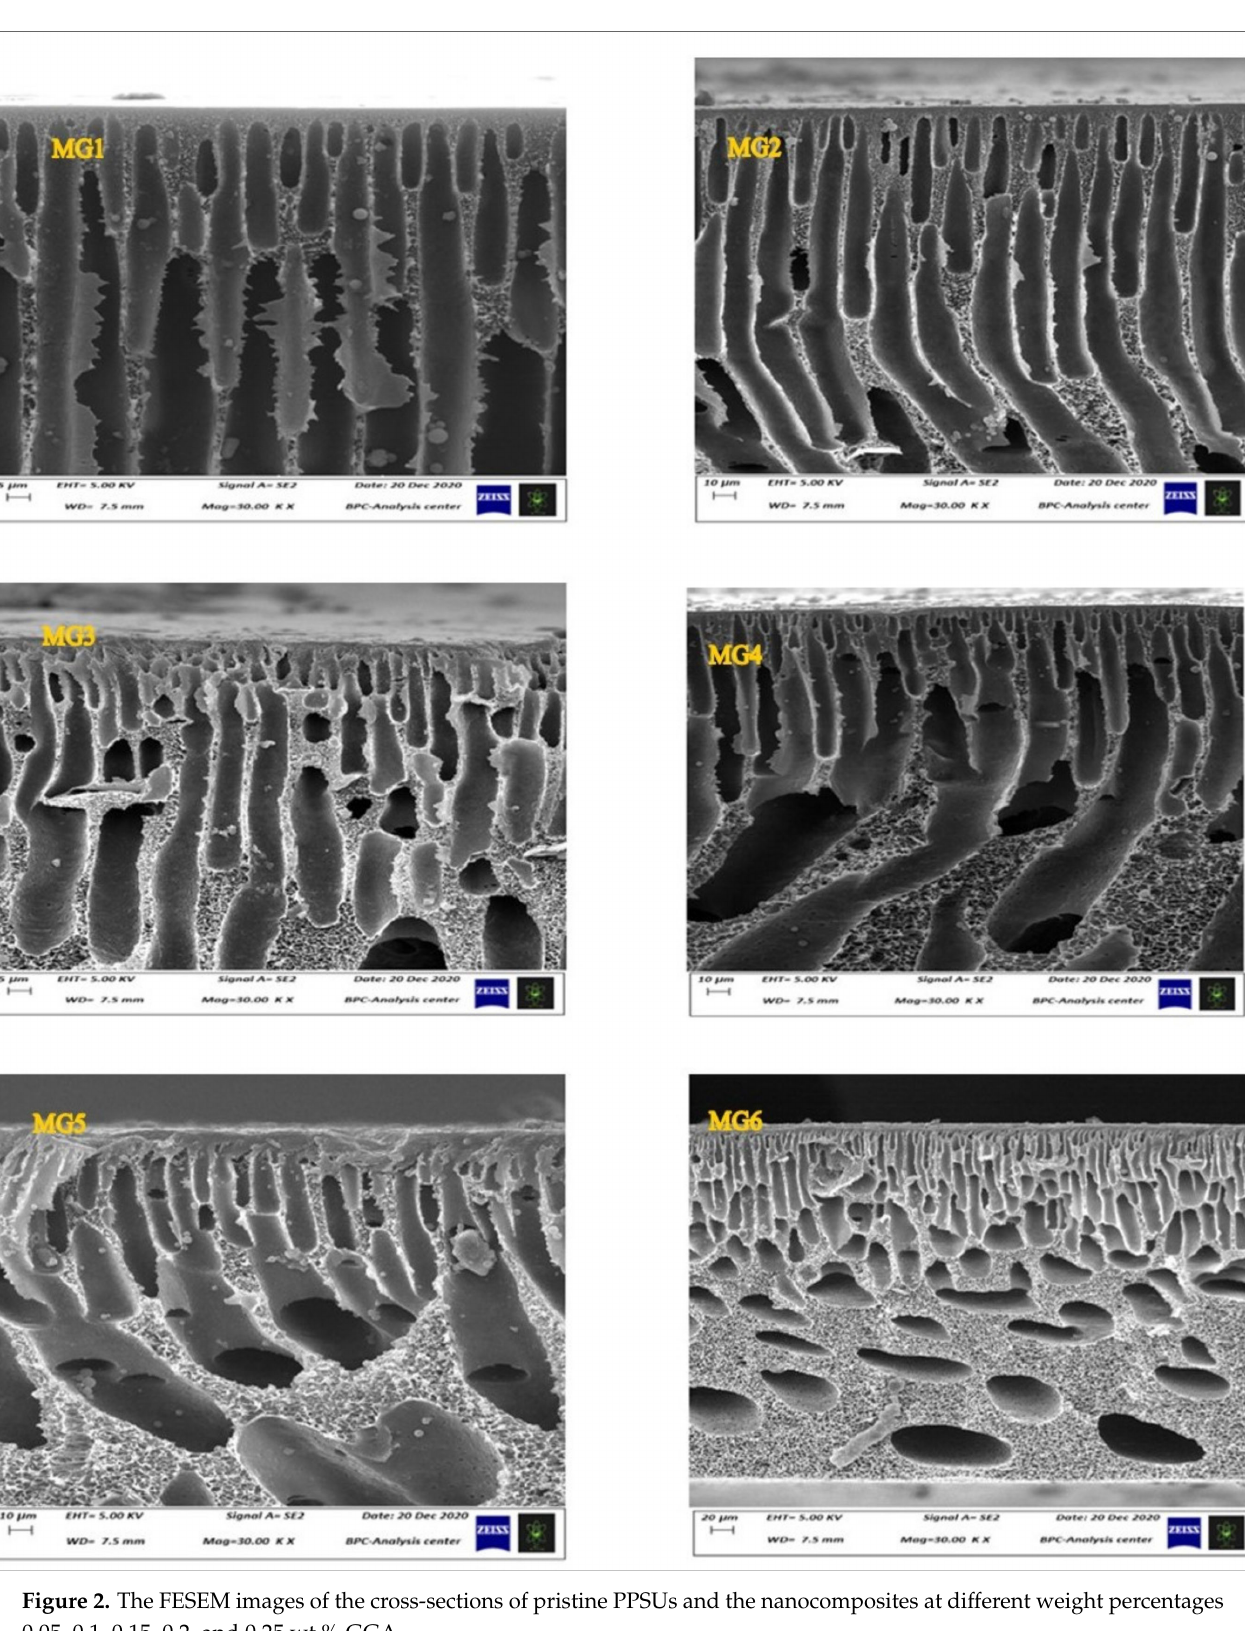
Figure 2. The FESEM images of the cross-sections of pristine PPSUs and the nanocomposites at different weight percentages 0.05, 0.1, 0.15, 0.2, and 0.25 wt.%